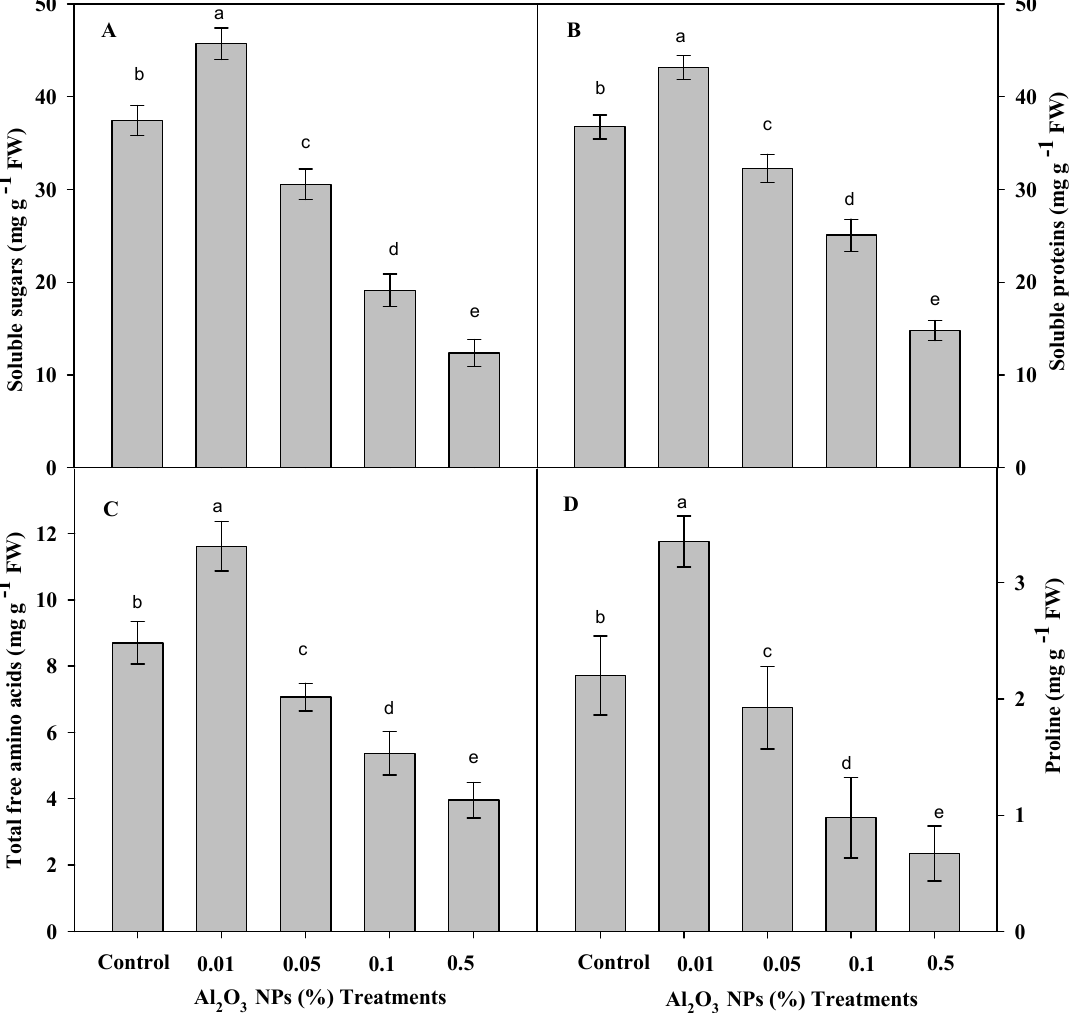
Figure 4. E ff ects of seed-priming with aluminum nanoparticles (Al 2 O 3 NPs) on ( A ) soluble sugar, ( B ) soluble protein, ( C ) total free amino acid, and ( D ) proline in roselle plants. Bars represent standard deviation ( ± SD) of the means ( n = 3). Di ff erent letters indicate significant di ff erences among the treatments at p < 0.05, according to Duncan’s multiple range